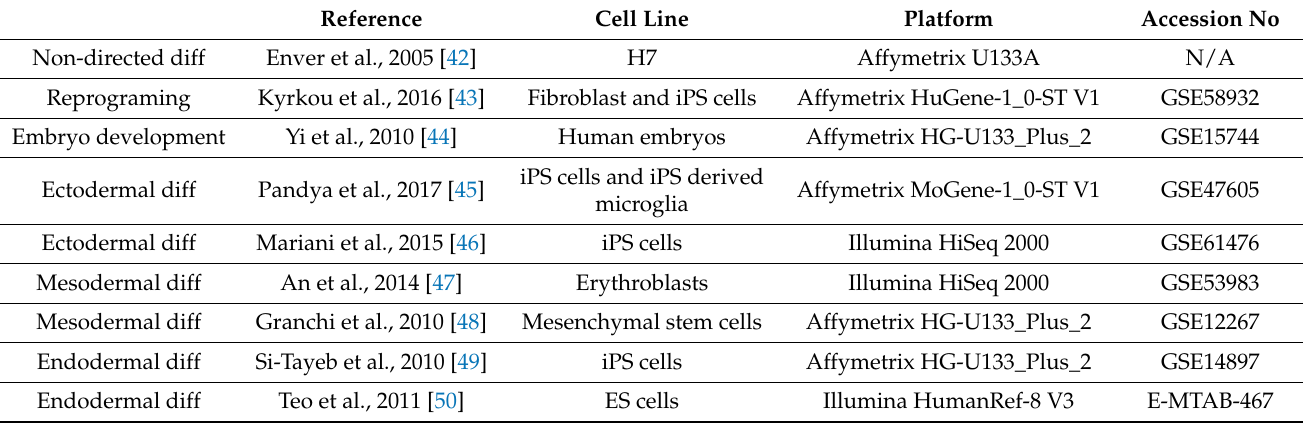
Table 1. Expression microarray and RNA-seq studies selected from the Stemformatics platform (https://www.stemformatics. org./). N/A = not